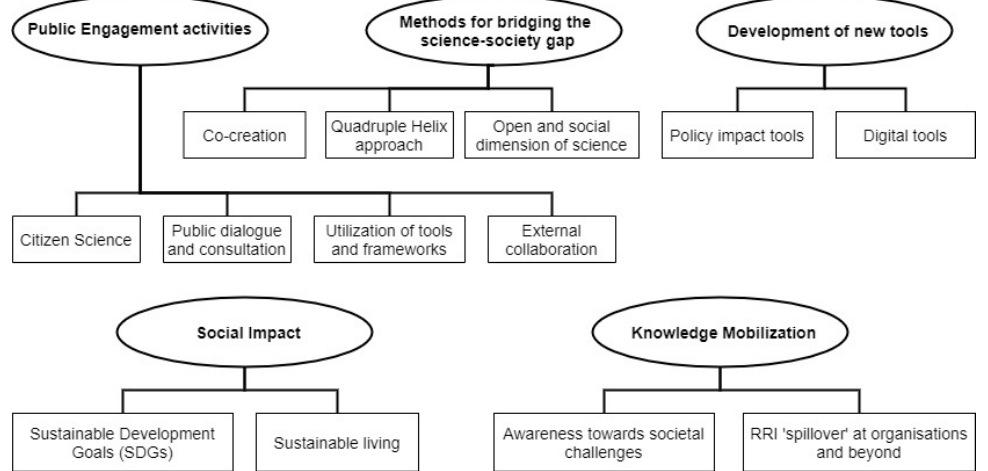
Figure 4. Final thematic map with five themes and thirteen